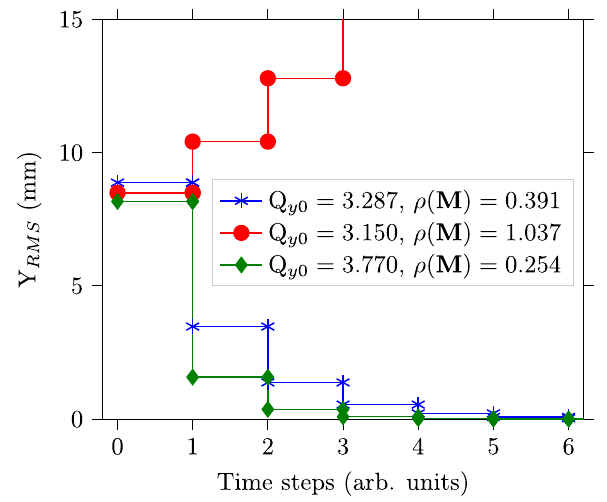
FIG. 8. Simulated closed orbit RMS over successive time steps of correction in MAD-X for a fixed Δ Q ¼ − 0 . 079 in the slow regime of